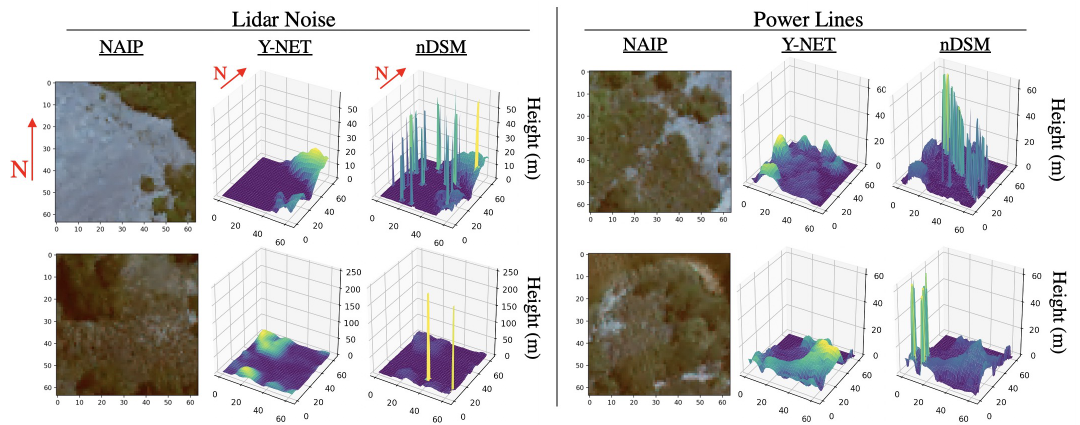
Figure 10. Examples of noise in our study site caused by LiDAR anomalies and power